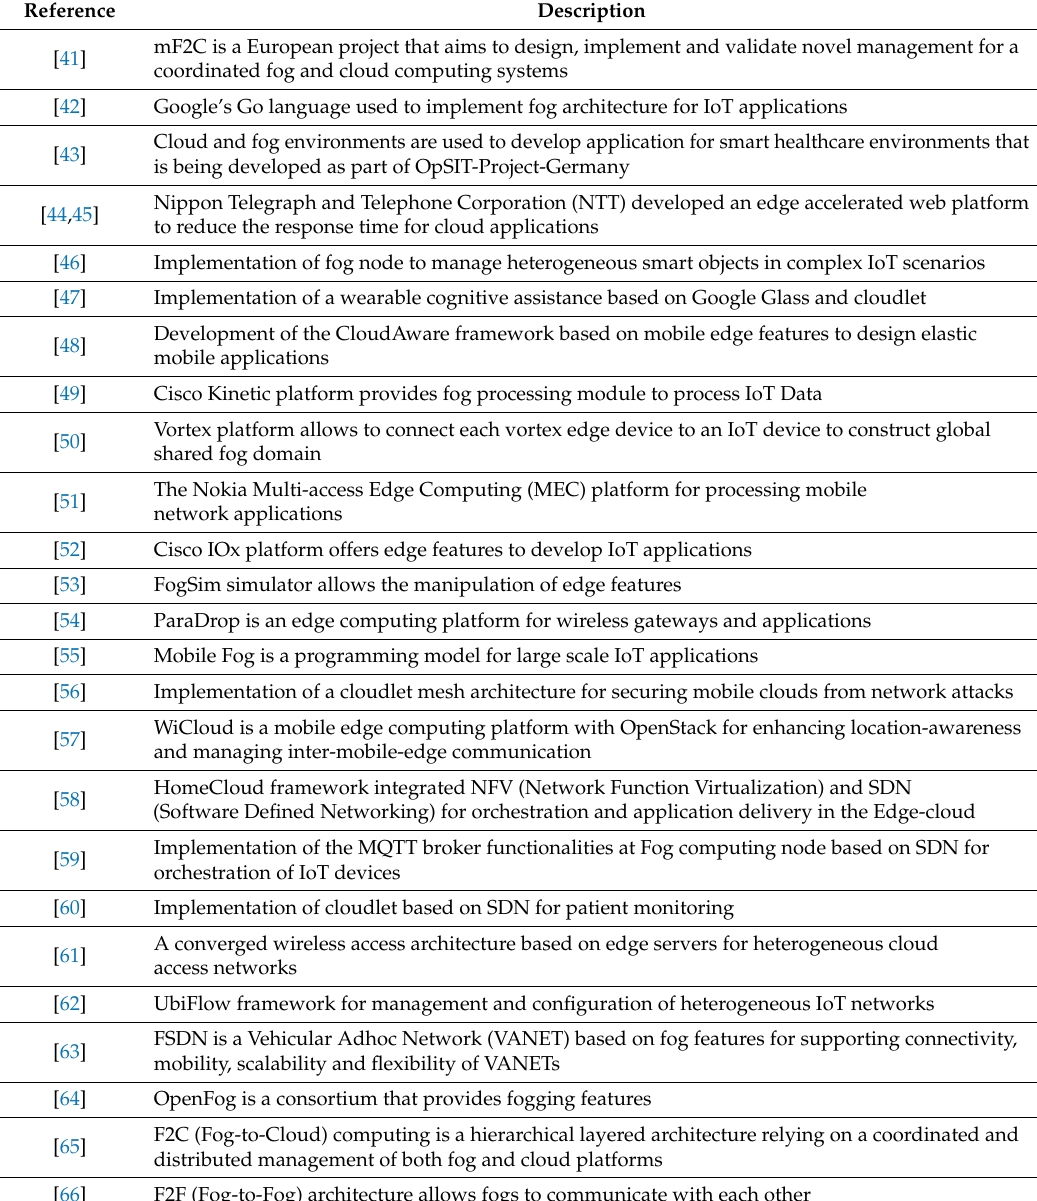
Table 2. An overview of edge computing